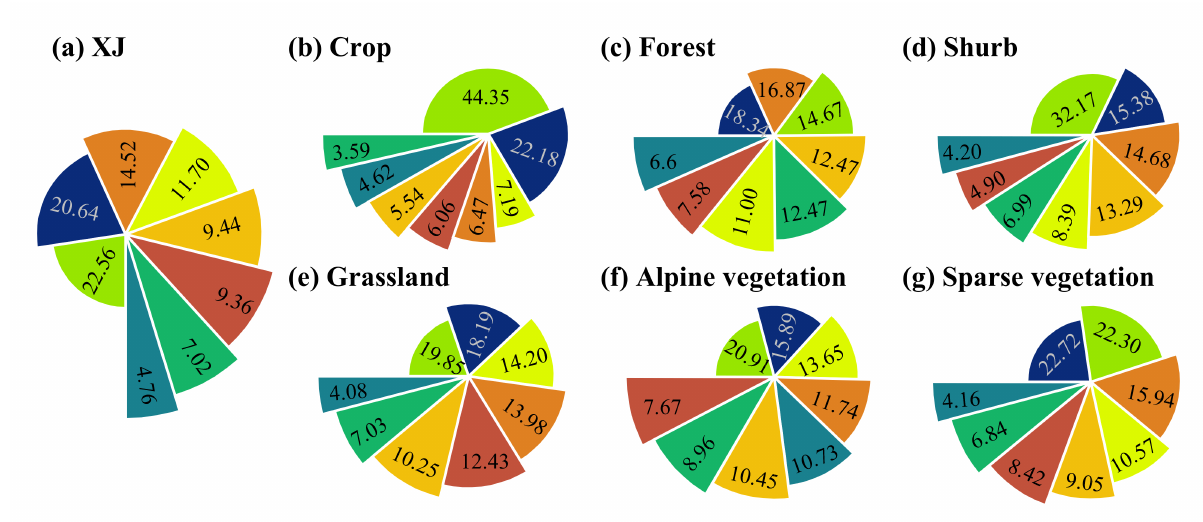
Figure 11. Percentage statistics of the evolutionary trends of anthropogenic impacts on vegetation dynamics. ( a ) Xinjiang; ( b ) crop; ( c ) forest; ( d ) shrub; ( e ) grassland; ( f ) alpine vegetation; ( g ) sparse vegetation. The legend is the same as that of Figure